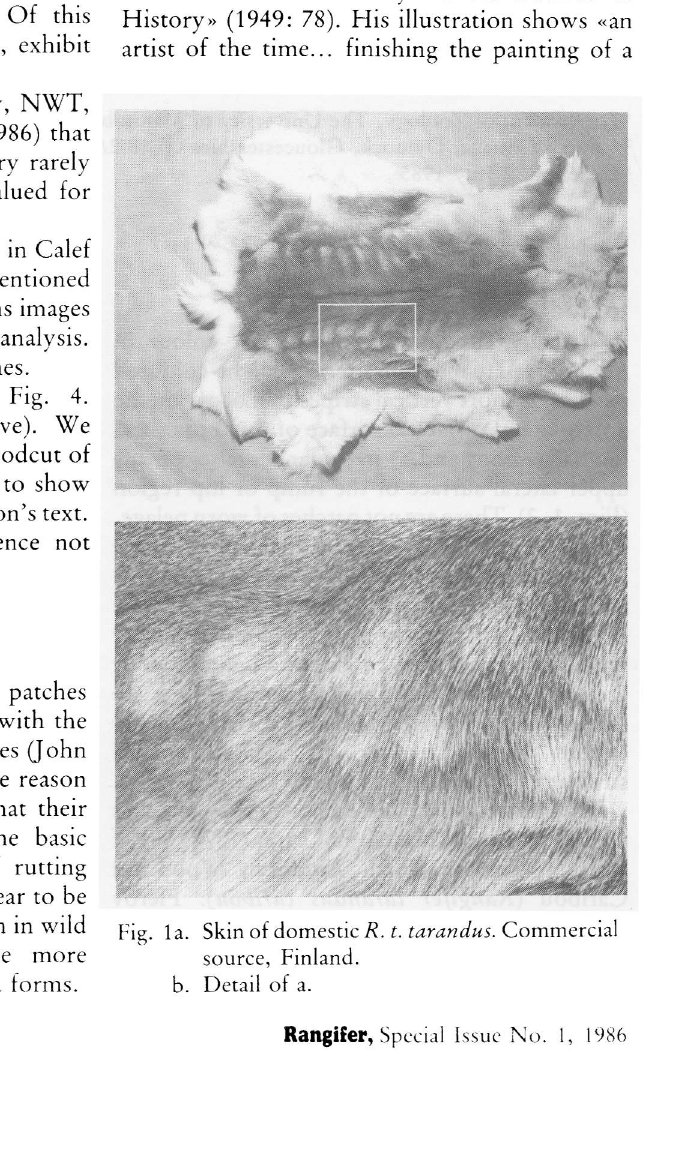
Fig. la. Skin of domestic R. t. tarandus. Commercial source, Finland, b. Detail of